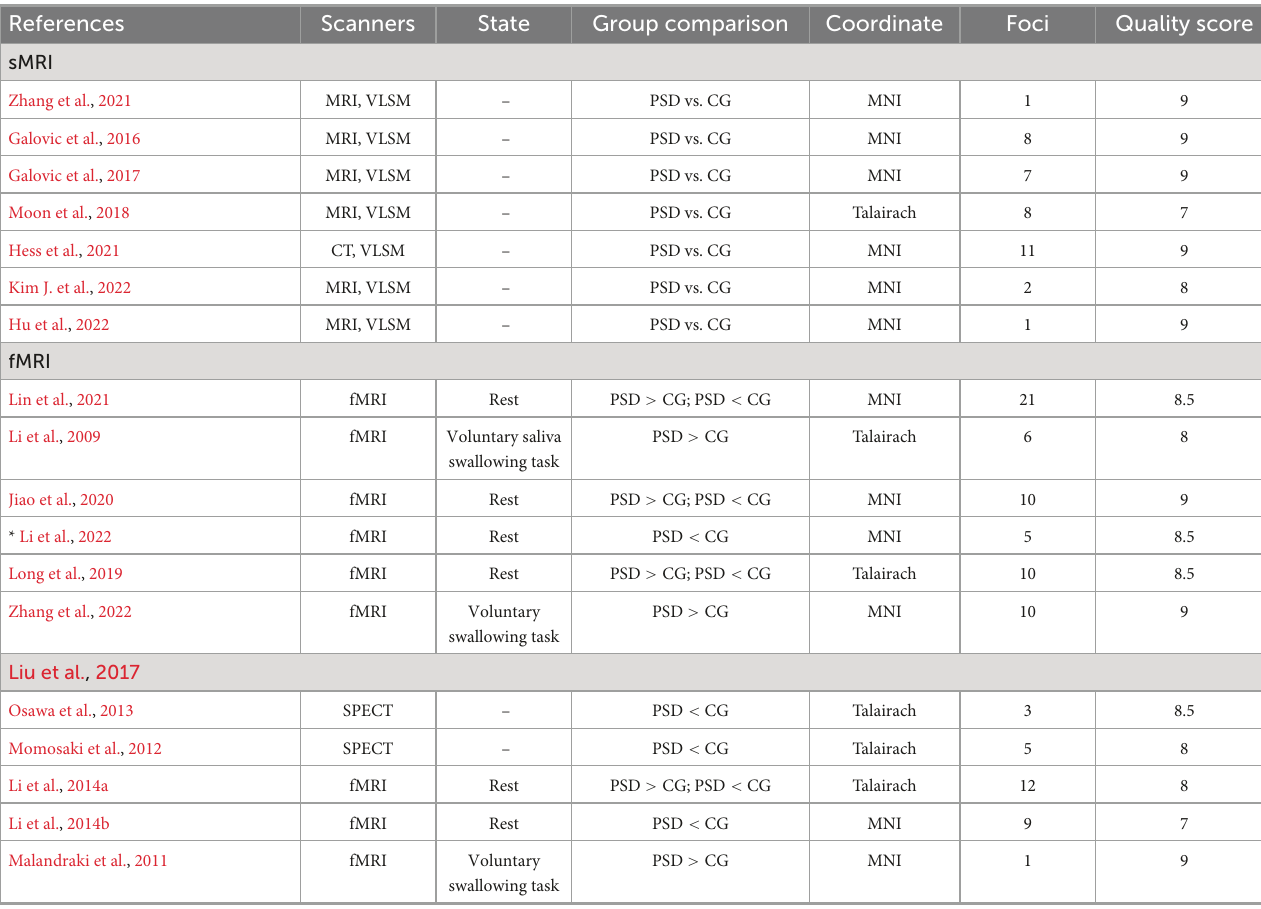
TABLE 1 Summary of technical and literature quality of studies included in structural activation likelihood estimation (ALE) analysis and functional ALE